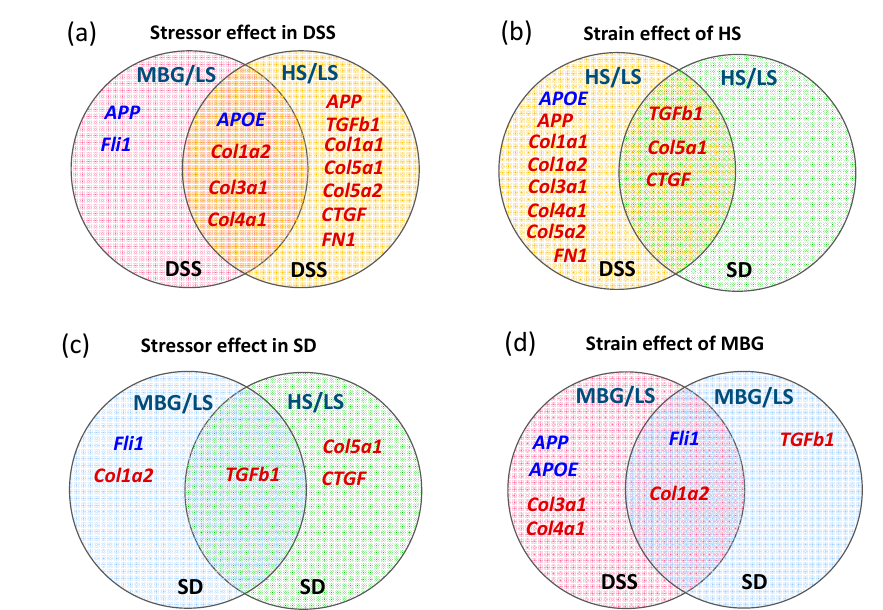
Figure 6. Venn diagrams of the expression of profibrotic and AD-related genes. ( a ) The effect of marinobufagenin (MBG) and high-salt diet (HS) in comparison to low-salt diet (LS) in Dahl salt- sensitive (DSS) rats. ( b ) The effect of the HS in comparison to LS in DSS vs. Sprague–Dawley (SD) rats. ( c ) The effect of MBG and HS in comparison to LS in SD rats. ( d ) The effect of MBG in comparison to LS in DSS vs. SD rats. The graphic presentation is based on the qPCR data (Tables 4 and 5). The genes that are downregulated in comparison to the LS control are presented in blue and the genes that are upregulated in comparison to LS control are shown in red. The genes in the intersecting areas are shared between the compared groups.